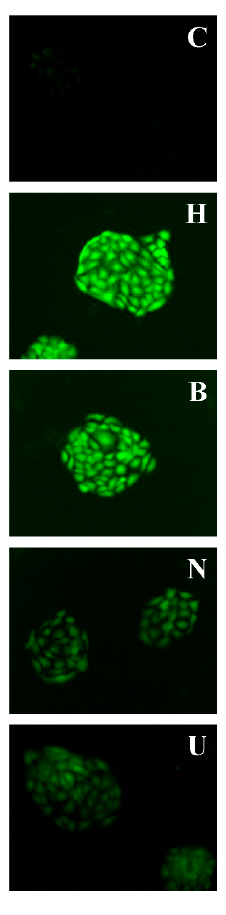
Figure 7. Analysis of reactive oxygen species (ROS) in HaCaT cells. Representative fluorescence photomicrographs (objective 40×) of DCFH-DA staining output via fluorescence microscopy. C: Normal culture group; H: Only oxidative damage group; B: Blank-NLC-treated group; N: UB-NLC-treated group; U: Free UB-treated